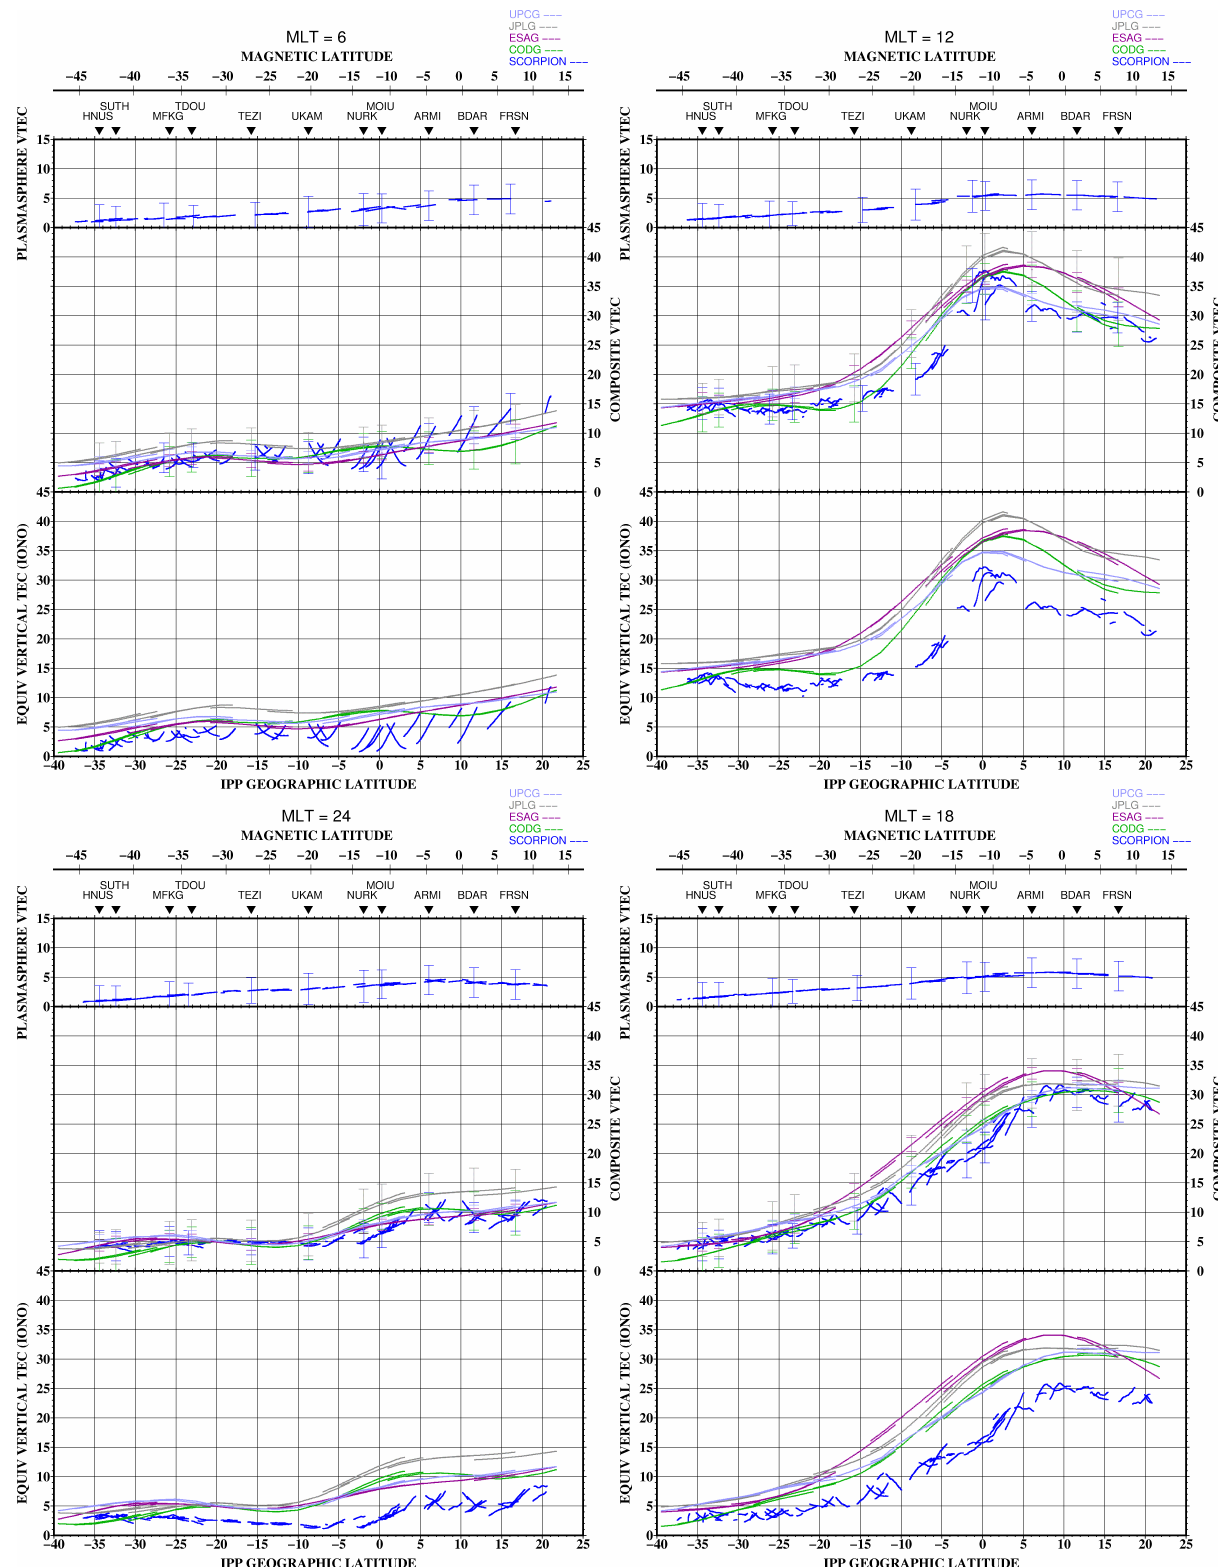
Figure 5. Latitudinal vertical TEC profiles for the separate ionosphere (bottom panel) and plasmasphere (top panel), with the composite vertical TEC (middle panel), for the SCORPION results and the CODE, ESA, JPL, and UPC IONEX maps, for magnetic local times (clockwise from upper left) 06:00, 12:00, 18:00, and